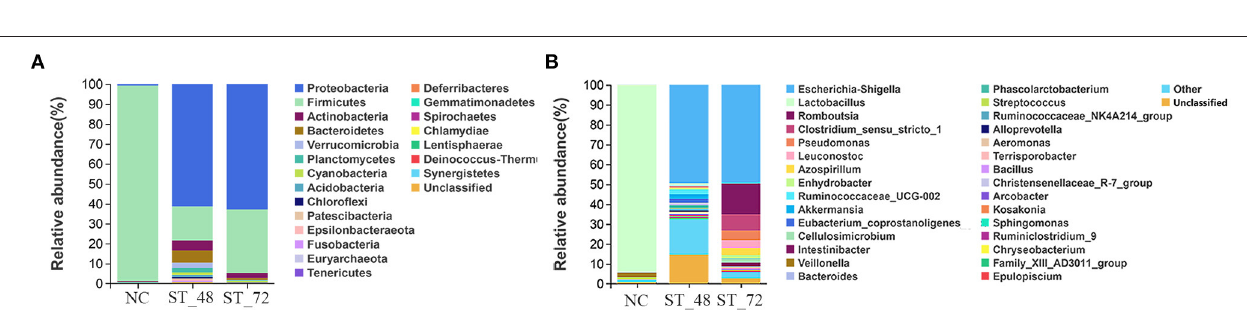
Ruminococcaceae _ UCG _ 003 , Variovoram , Corynebacterium_1